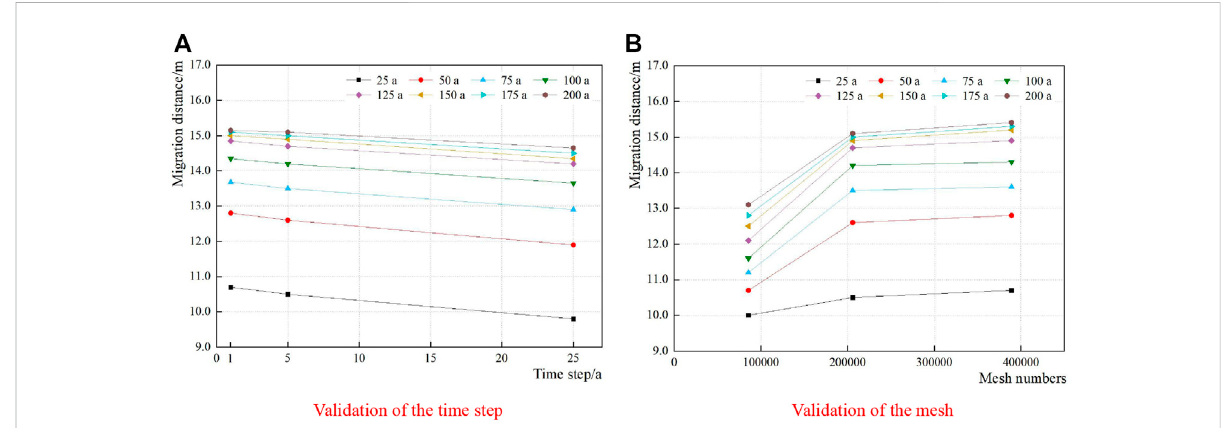
FIGURE 4 Validation of the time step and the mesh. (A) Validation of the time step (B) Validation of the mesh.